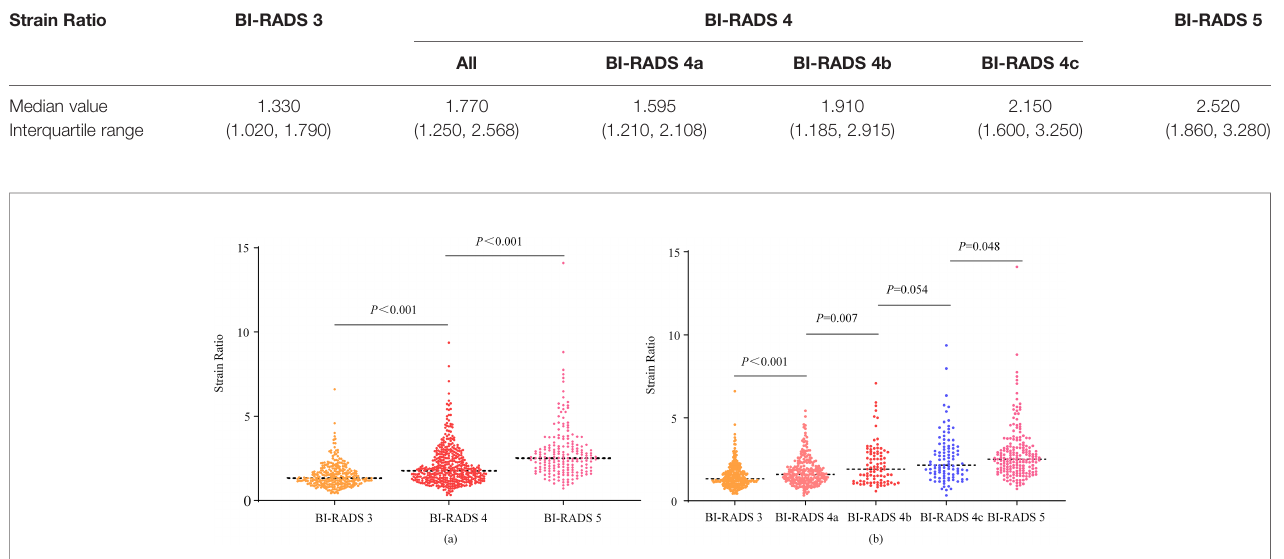
FIGURE 3 | Scatter plots of strain ratios in different BI-RADS classi fi cations. The Mann-Whitney U test was used to compare the difference in strain ratio between different BI-RADS classi fi